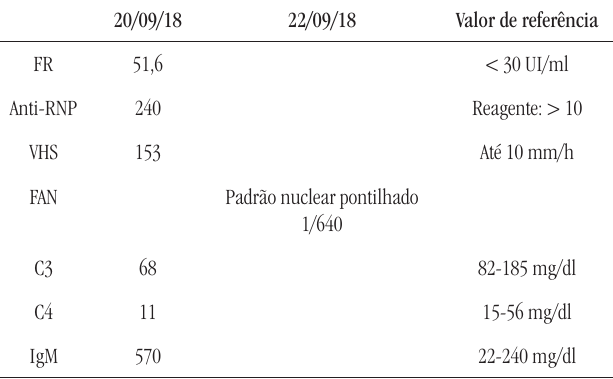
TC de tórax, abdômen e pelve: hemograma completo, esfregaço de sangue periférico, eletroforese de proteínas séricas, imunoeletroforese de soro (imunofixação), média das concentrações de imunoglobulinas no soro, imunofenotipagem de linfócitos B circulantes, título de anticorpo antinuclear, antiácido desoxirriblonucleico (anti-DNA), anticardiolipina, anticoagulante lúpico, testes de HIV, HCV e vírus da hepatite B (HBV) e aspirado de medula óssea/biópsia (9) . Não há estudos sistêmicos ou randomizados sobre o tratamento da SE, que continua a ser um desafio. Os métodos terapêuticos (além de glicocorticoides, IVIG e esplenectomia) relatados como bem-sucedidos em alguns pacientes foram: rituximab, ciclofosfamida, micofenolato de mofetil, ciclosporina, vincristina, danazol, transplante de células hematopoéticas e azatioprina (6, 8)